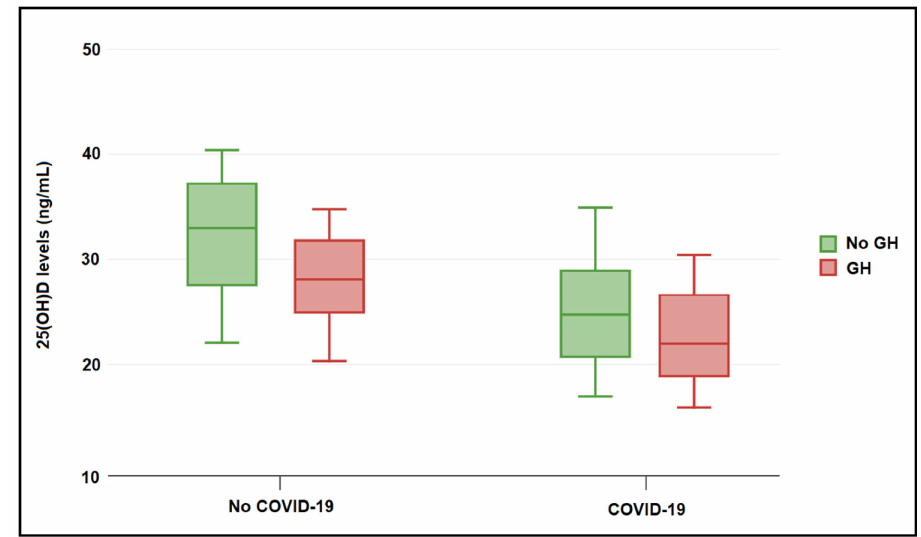
Figure 2. The relationship between COVID-19 and vitamin D levels in pregnant women with and without gestational hypertension (GH) at initial measurement. Data presented as median (IQR) and analyzed with the Mann–Whitney U test. Table 4. Correlation analysis of the studied